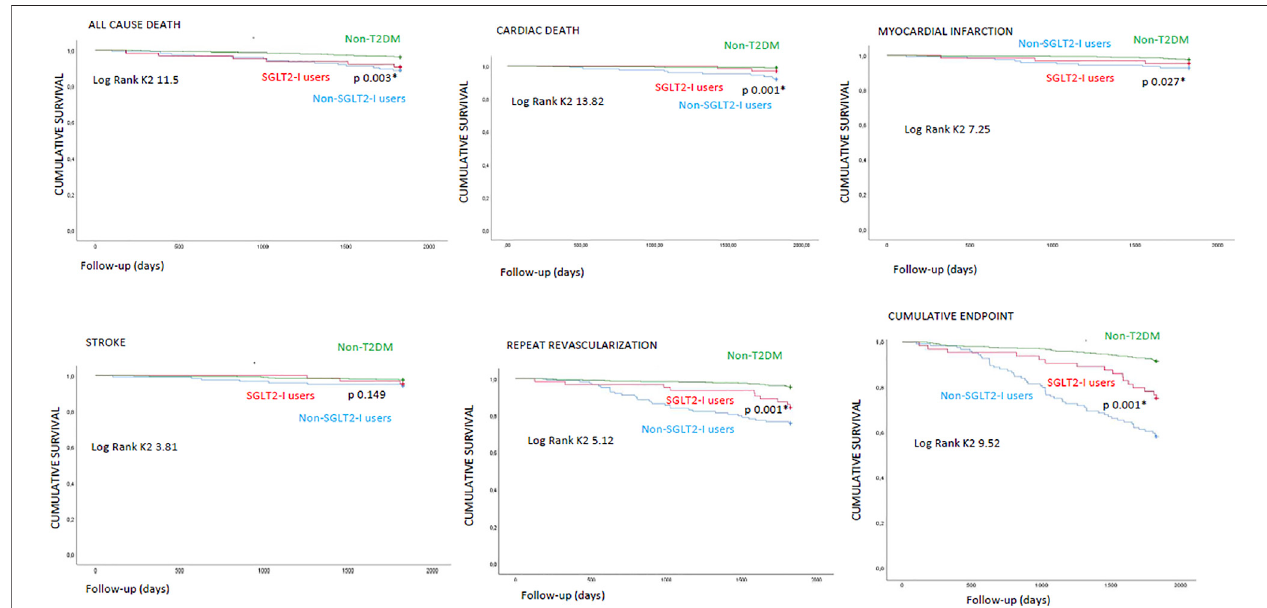
FIGURE3| Kaplansurvivalcurvesinnon-diabetics(non-T2DM)vstype2diabetesmellitus(T2DM)patientsundersodium-glucosetransporter2inhibitors(SGLT2- I users) vs T2DM patients without SGLT2-I (non-SGLT2-I users) for study clinical outcomes. * is for statistical signi fi cant ( p < 0.05).